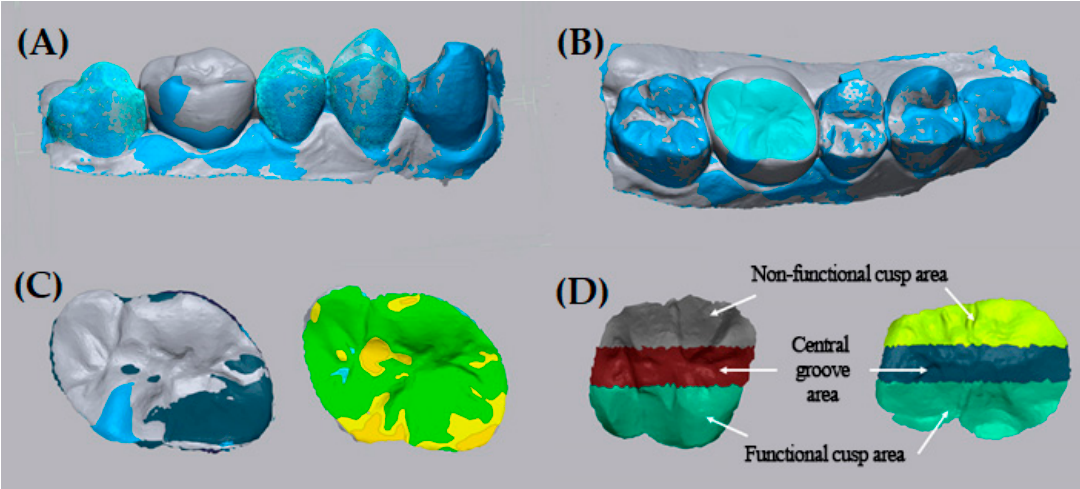
Figure 4. Data processing of the experimental groups. ( A ) The field of interest for the superimposition was limited to two premolars and one molar, except for the treated tooth. ( B ) Selection of the occlusal surface. The area not belonging to the occlusal surface was removed. ( C ) 3D comparison using surface analyzing software. For the entire occlusal surface and outside of the tolerance area, the representative values of the occlusal error were calculated. A color-coded map was generated for comparison. ( D ) To analyze the amount of occlusal error according to the functional properties of the occlusal surface, the occlusal surface was split into three areas. The representative values of occlusal error from each subdivided area were calculated.